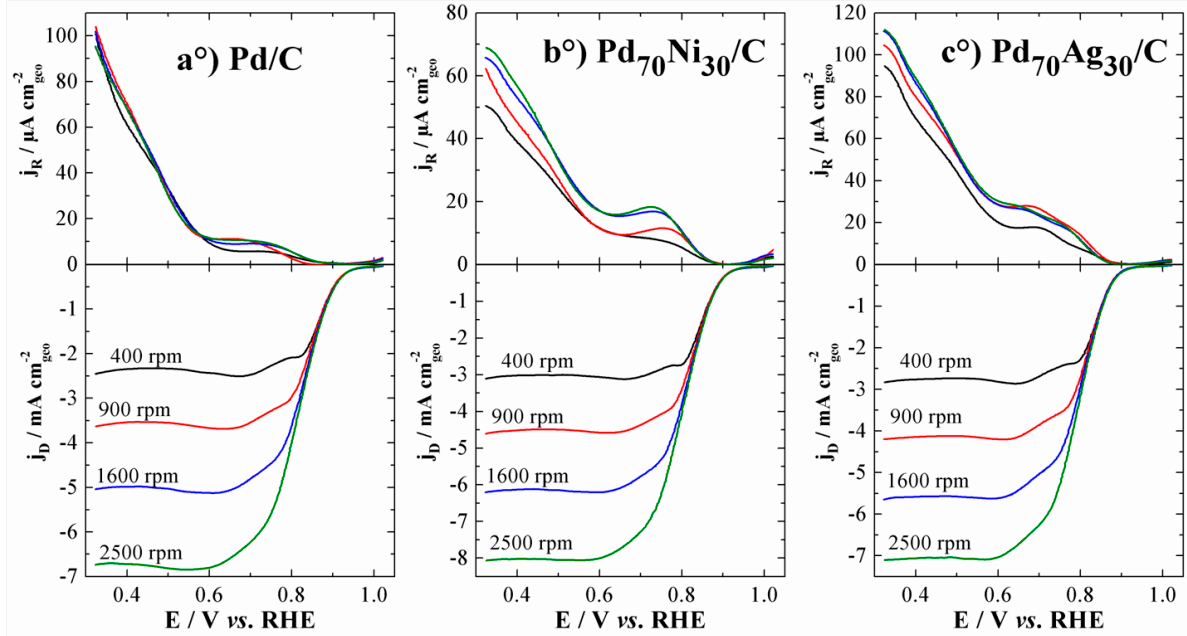
Figure 11. Disc ( bottom ) and ring ( top ) current-potential curves for ORR on ( a ) Pd/C, ( b ) Pd 70 Ni 30 /C and ( c ) Pd 70 Ag 30 /C electrocatalysts prepared from w/o method (20 wt%), in O 2 -saturated 1 M NaOH at 5 mV s −1 . Metal loading on the electrode ca . 100 µg cm − 2